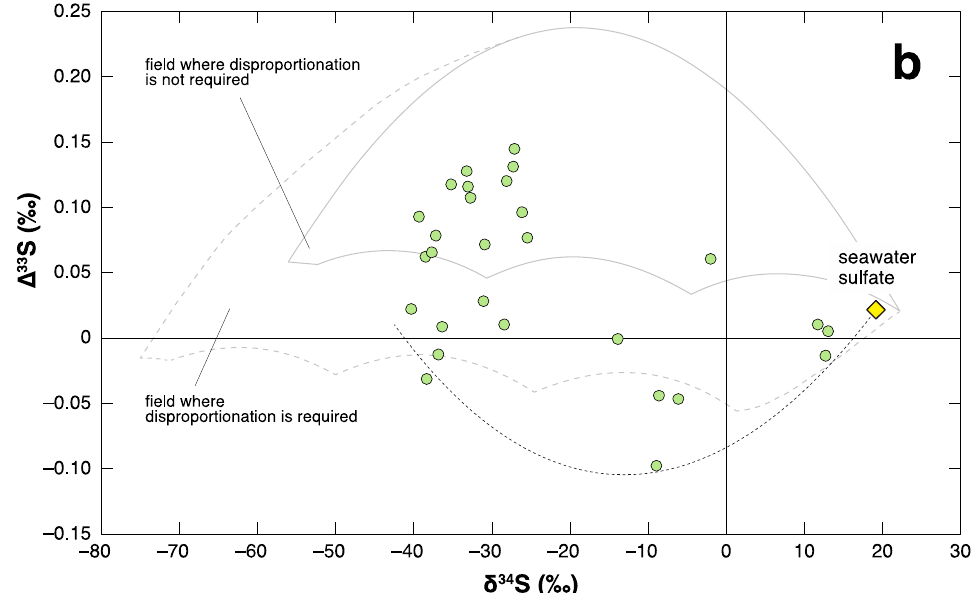
Figure 9. Multiple sulfur isotope record across the P-TB at Gujo-Hachiman [67]. ( a ) sulfur isotope chemostratigraphy. A red line represents the estimated extinction horizon. A Roman numeral along the log is unit name; ( b ) δ 34 S– ∆ 33 S cross plot. The estimated δ 34 S and ∆ 33 S values of contemporaneous seawater sulfate are from Wu et al. [68]. A possible mixing curve is after Zhang et al. [67].